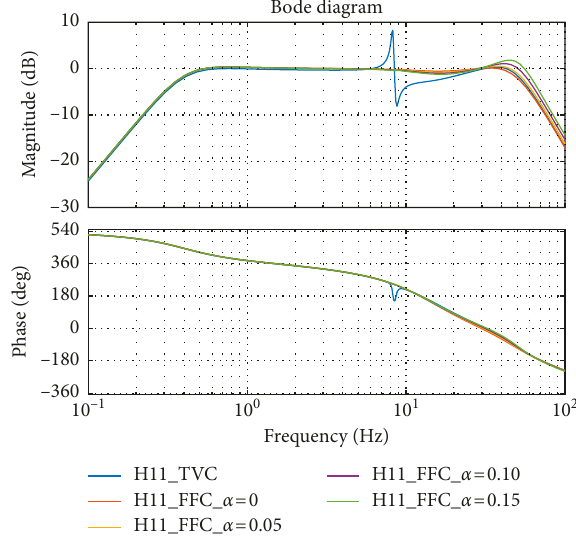
Figure 17: Effect of acceleration sensor error on the Bode diagram of H 11